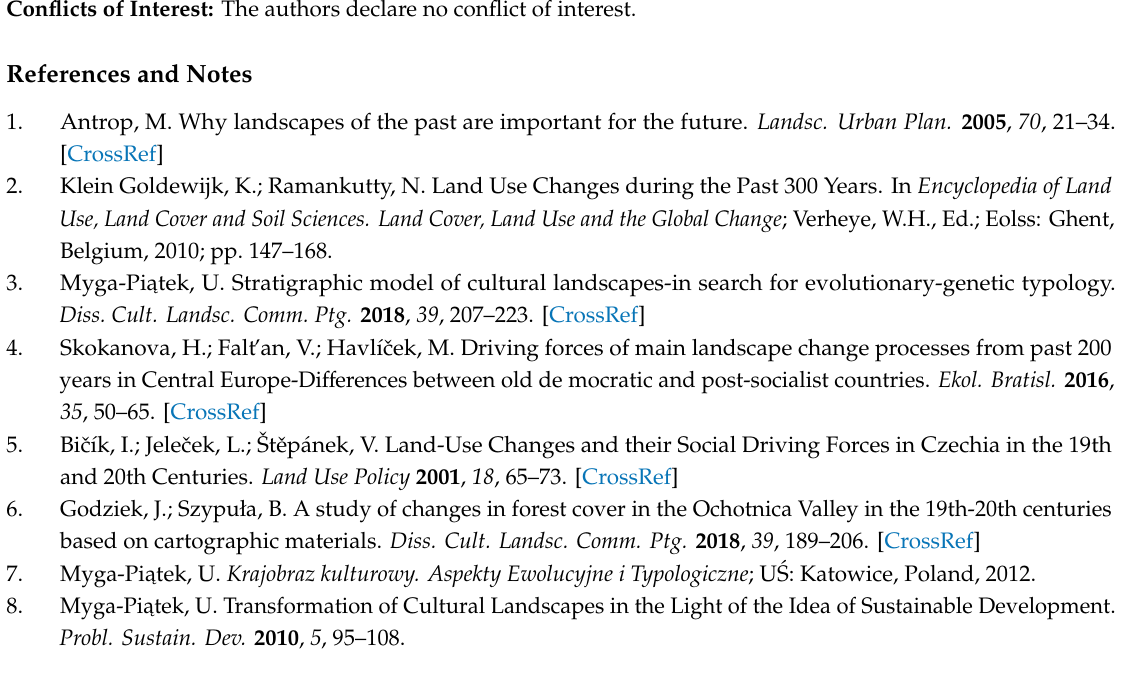
Table S1: Changes in visibility range in the period